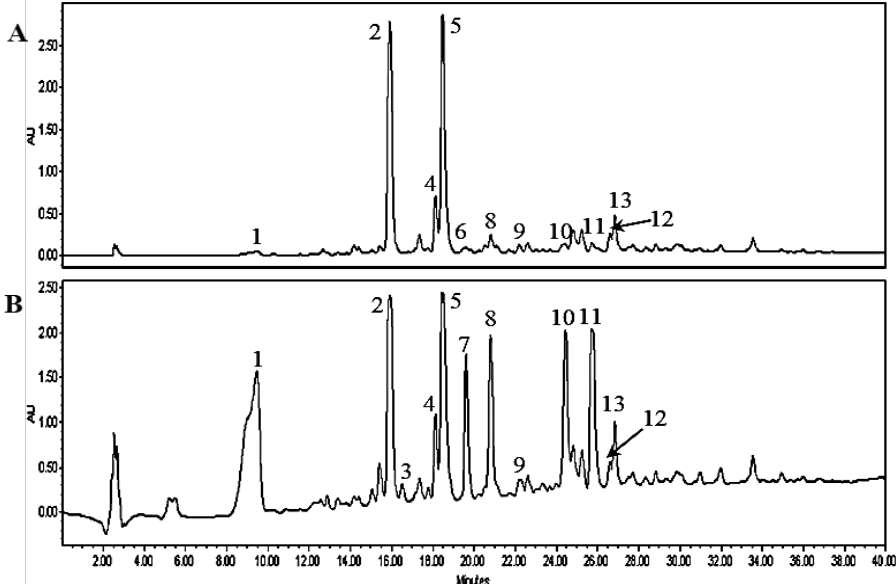
Figure 1. HPLC-PDA profiles of 70% MeOH extract of M. tricuspidata twig. ( A ) 280 nm; ( B ) 220 nm.